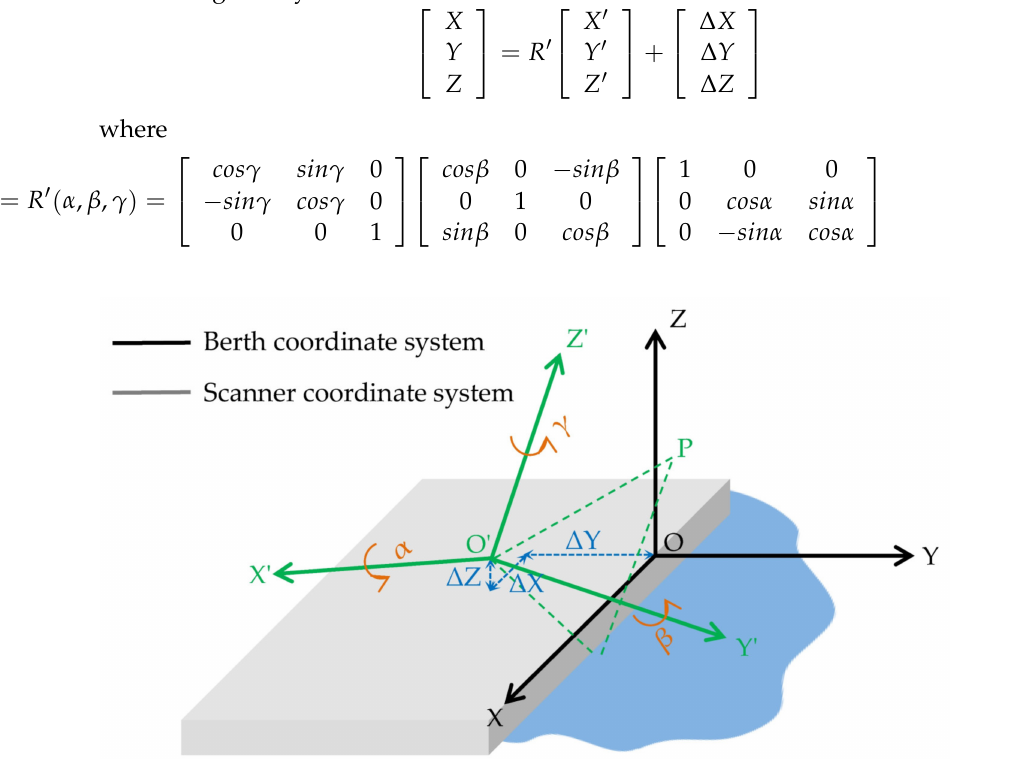
Figure 3. Conversion from scanner coordinate system to berth coordinate